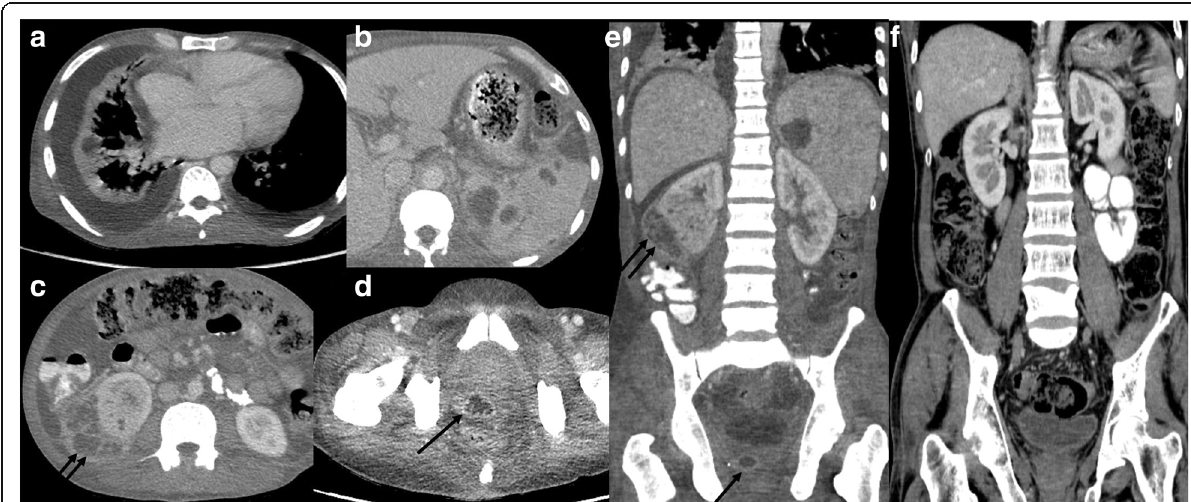
Fig. 3 Disseminated melioidosis. Forty-three-year-old gentleman with pyrexia of unknown origin and anaemia, axial CT lower thorax reveal ( a ) bilateral pleural effusion with small evolving abscess in the atelectatic lung, bilateral pleural effusion, ( b ) multiple splenic abscesses, ( c ) large right renal abscesses with large subcapsular collection (double arrow), ( d ) prostatic abscess (single arrow). e Coronal CT abdomen images also demonstrate the same findings. f Follow-up CT of the abdomen after 6 months revealed complete resolution of the abscesses in various